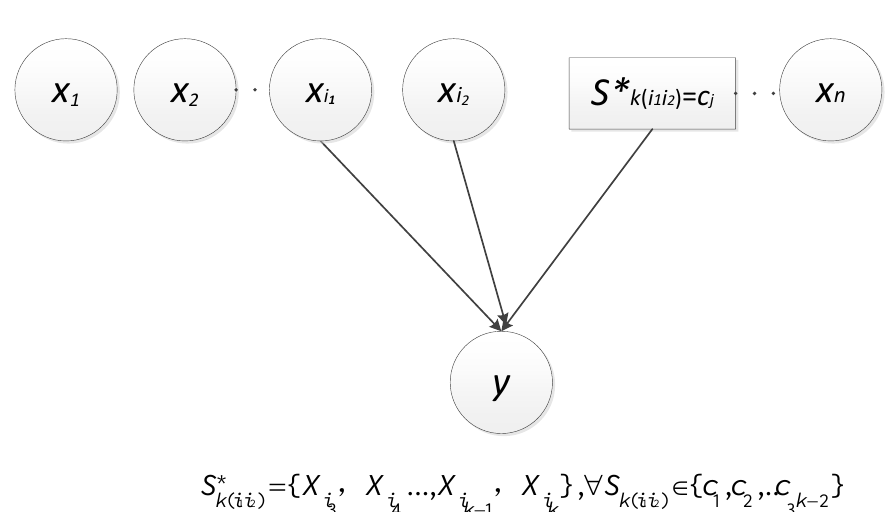
Figure 1. Direct dependence.